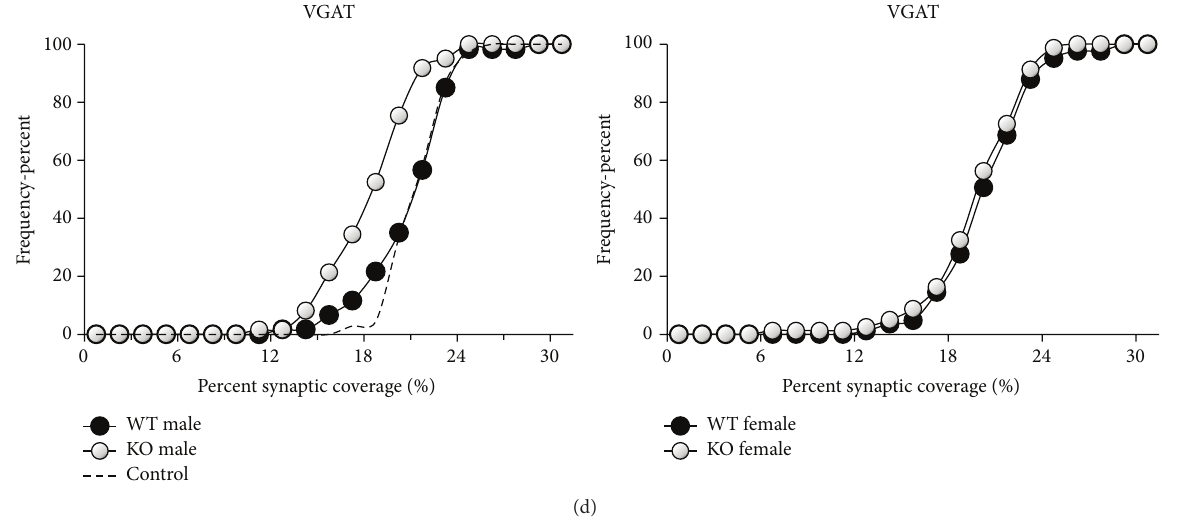
Figure 3: Cumulative frequency plots of percent coverage by structures immunoreactive to different synapse-associated proteins onto the soma and proximal-most dendrites of labeled motoneurons in tamoxifen treated and untreated SLICK::trkB f / f male (left) and tamoxifen treated female (right) mice. WT (black symbols) refers to wildtype motoneurons in tamoxifen treated mice, without YFP, that still retain trkB receptors. KO (white symbols) refers to knockout motoneurons labeled with YFP that do not have trkB receptors. Control (dashed line) refers to data from male SLICK::trkB f / f mice not treated with tamoxifen. Data from all the mice in each group were pooled. (a) VGLUT1. (b) VGLUT2. (c) GAD67. (d) VGAT.